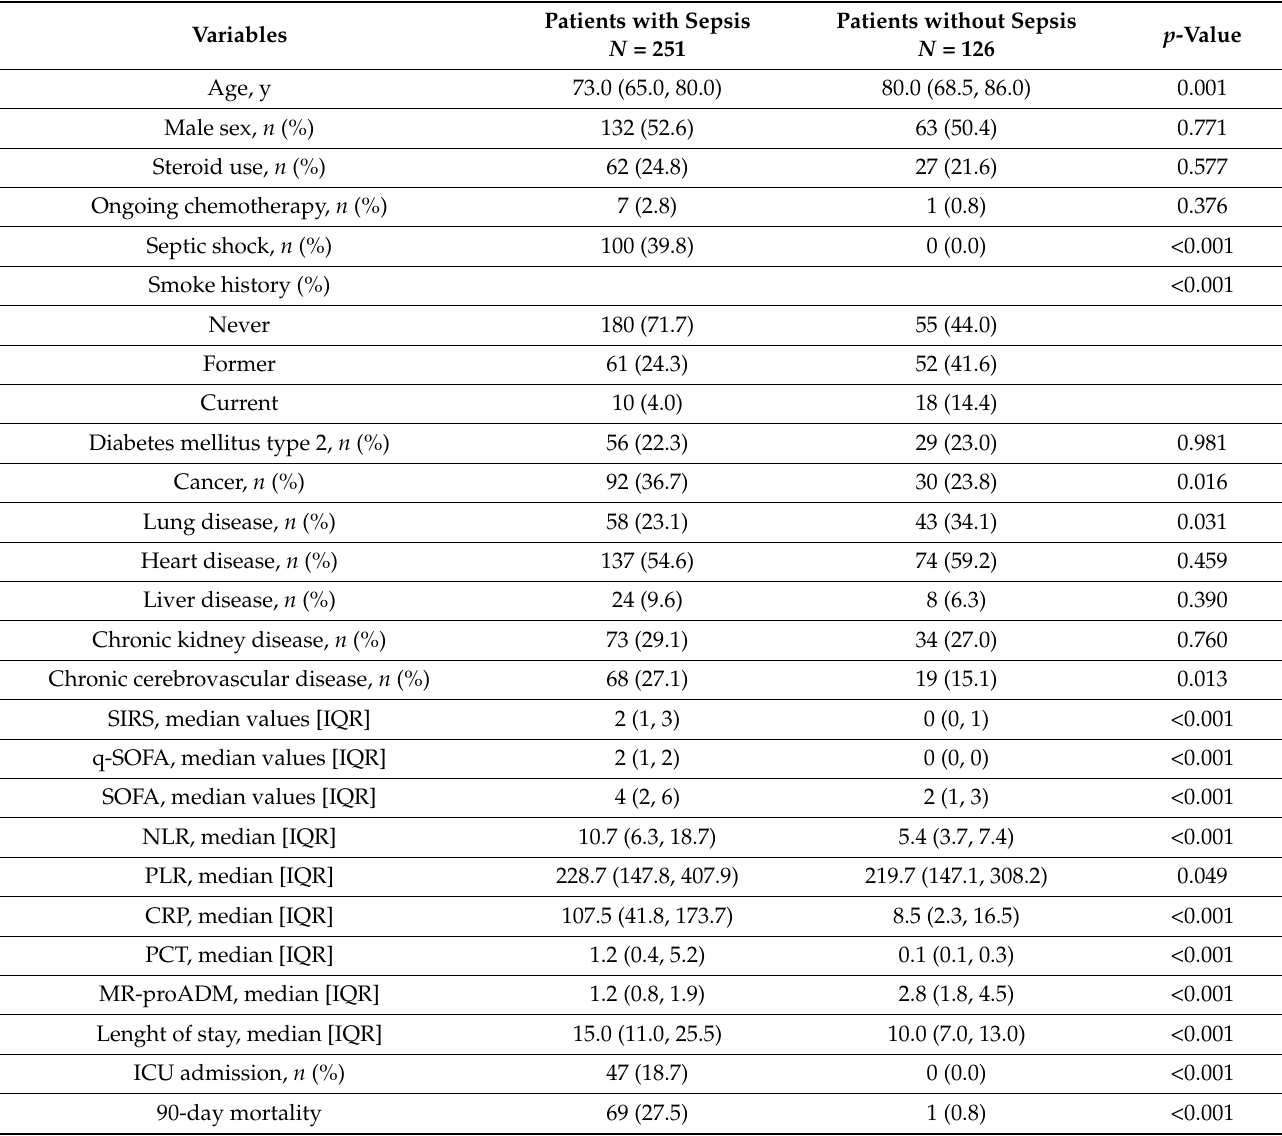
Table 1. Baseline patients’